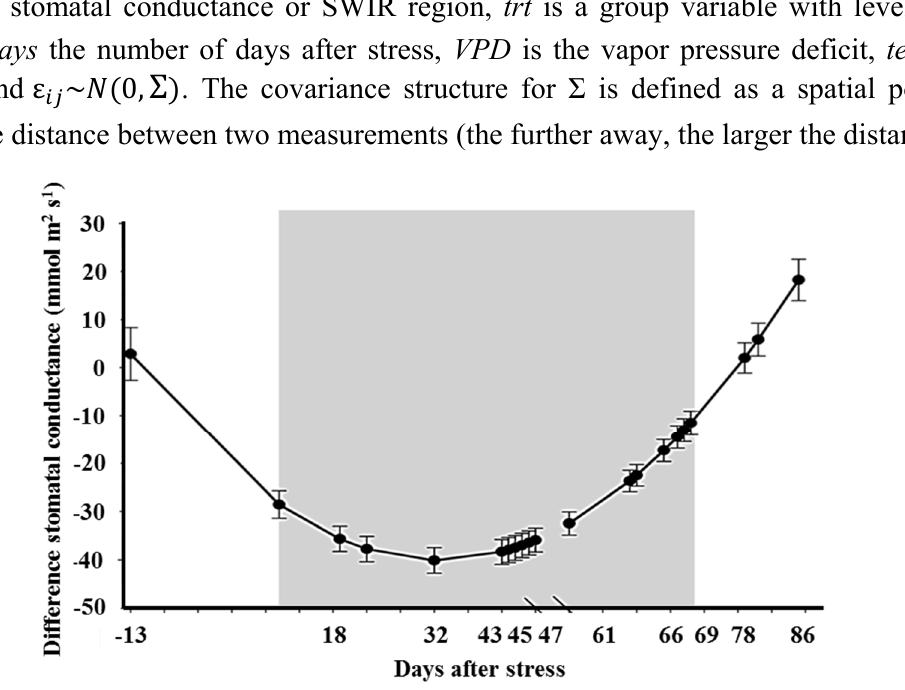
Figure 6. Model-based estimated difference for stomatal conductance. The shaded area shows the time points that were statistically different. The break in the horizontal axis between 47 and 52 days after stress separates the period of water stress from recovery. Error bars are the standard errors; n =